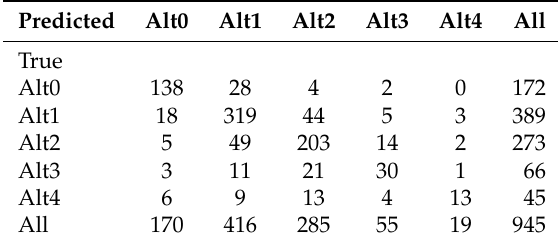
Table 7. kNN model alteration predictions.